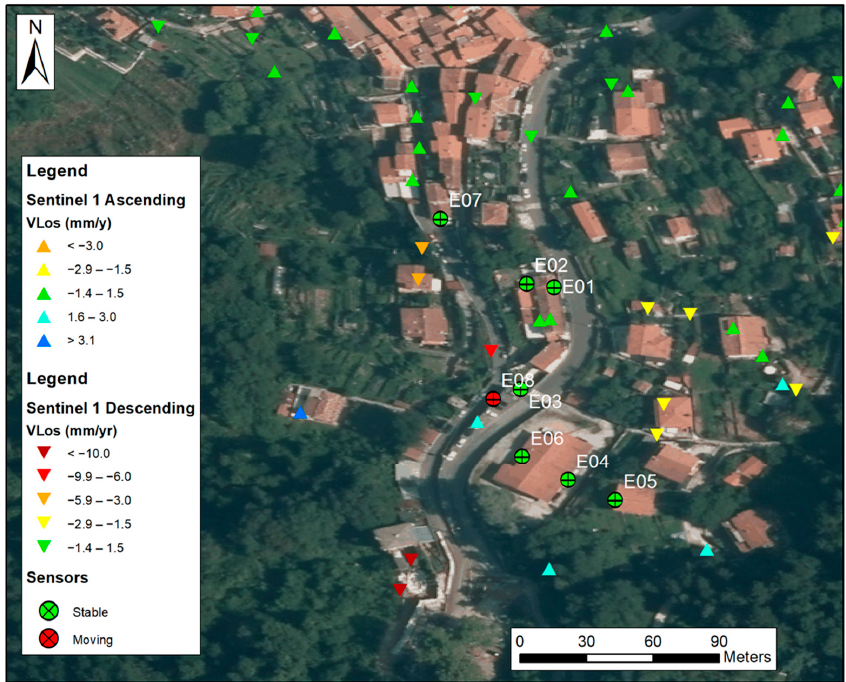
Figure 12. Spatial comparison between MT-InSAR Sentinel 1 data and deformation measured by the wireless sensor network. Colored circles correspond to selected time series for the comparison with extensometer data of Figure 12: black: E1; orange: E3; blue: E6; red: E4.